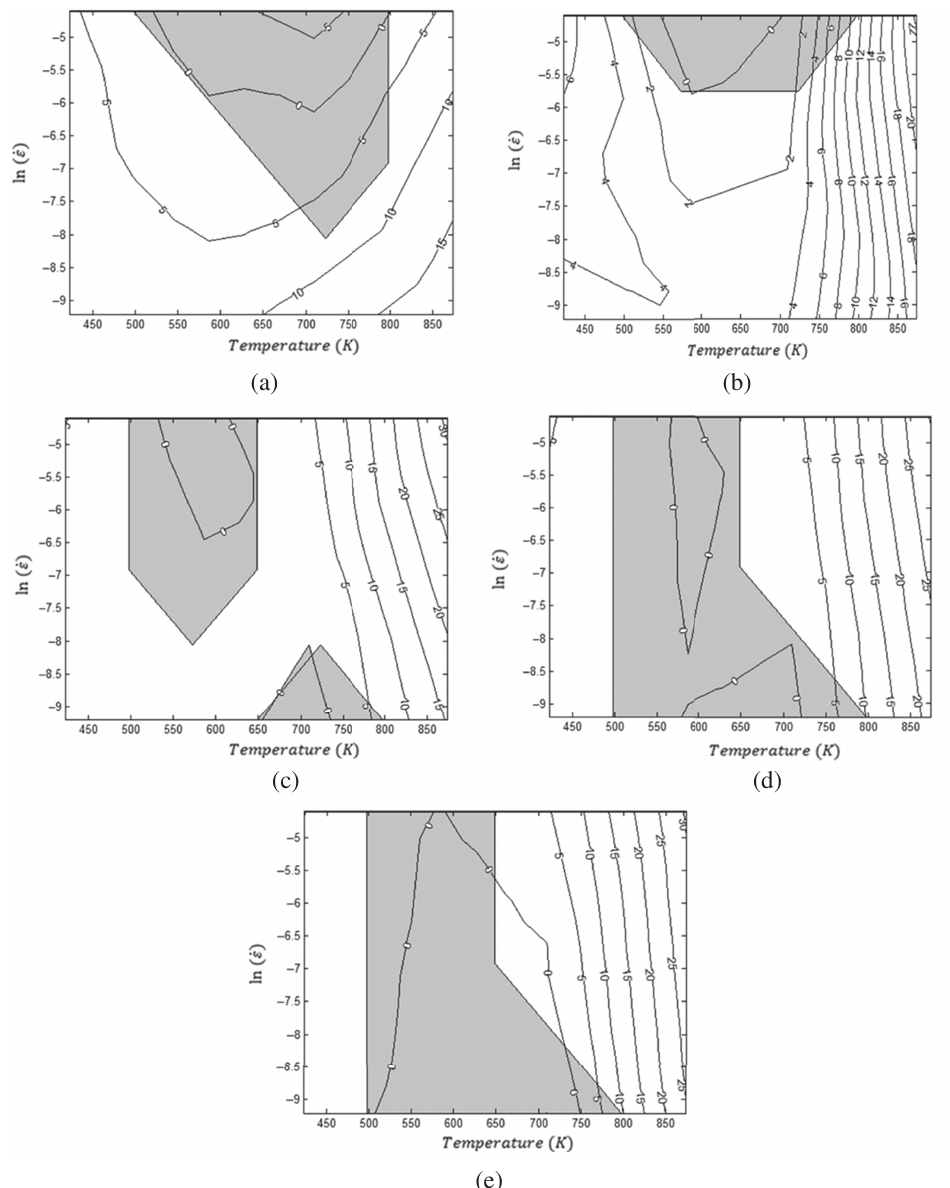
Figure 10: Processing maps of ASS 316 under different strain levels (a) 0.4 (b) 0.8 (c) 0.12 (d) 0.16 (e)